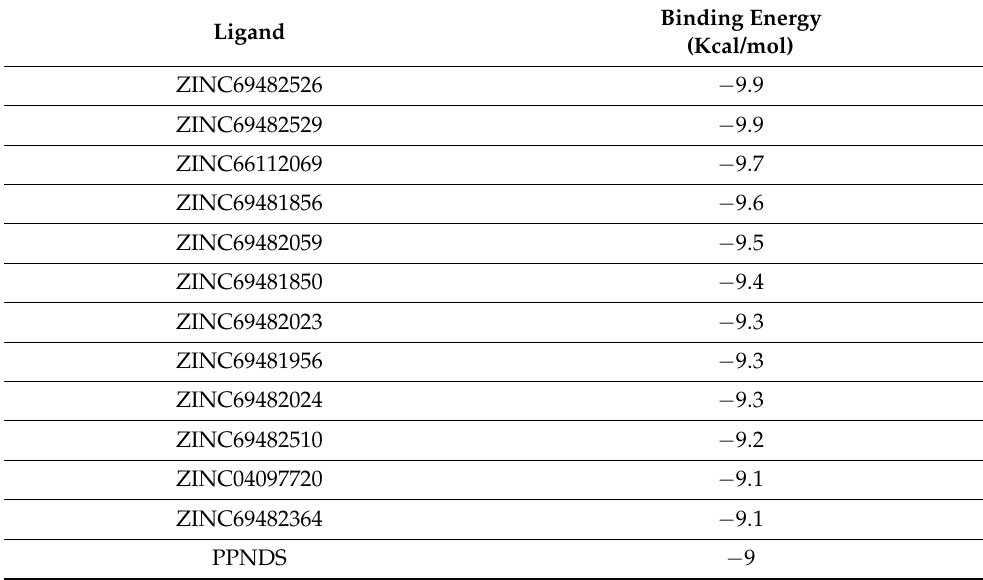
Table 1. List of compounds with higher binding affinity than the positive control.